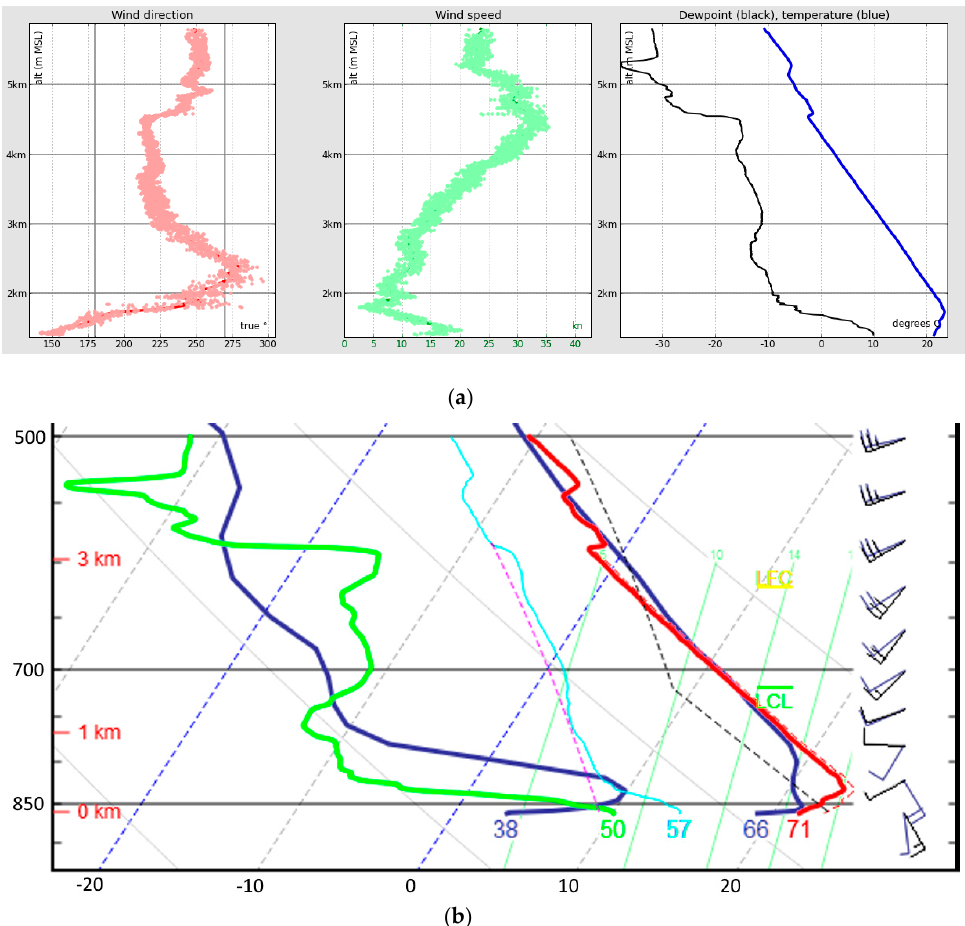
Figure 9. ( a ) Wind, temperature, and dew point profiles east of Alpine (103.5 W) from Windsond software. ( b ) Skew-T log-p plot comparing Windsond (red; green) to the 0400 UTC HRRR profile. Using a combination of HRRR, Windsond, and surface observations, vertical cross-sections of at 2200 and 0400 UTC illustrate the relation of the moist air mass to regional terrain (Figure 10). The cross-sections were analyzed using a subjective combination of mobile surface, fixed surface, radiosonde, and HRRR model data. The HRRR data from each model level were plotted at a 0.5 degree of longitude intervals and other strategic locations along the mobile track, and were adjusted to reduce local biases noted by comparison with radiosonde data. It is assumed that observed soundings provide ideal vertical resolution where available, surface mobile data provide ideal horizontal resolution of near-surface features, and the HRRR model data are able to broadly depict upper-air patterns between radiosondes. The 0.5 degree spacing of profiles appeared adequate to capture the scales of relevant coherent structures noted in model level plots, except near the surface, dryline, and areas of organized convection (not crossing the transect). Profiles were chosen closer together in the proximity of the dryline for Figure 10b. Near the soundings and near the surface, much more weight was given to the observed versus model data so that the horizontal dryline gradient and vertical inversion gradient could be represented better than through model data alone. The 15 km spatial displacement of the dryline by the HRRR was accounted for. A similar procedure was utilized by [20]. Between 2200 UTC and 0400 UTC, the cross-sections show the westward upslope retrogression of the dryline. The lowest 500 m or so on the moist side generally have mixing ratios greater than 8 g/kg, while air to the west of the dryline is well under 4 g/kg. The moist layer is trapped below a subsidence inversion, although the HRRR model does indicate some upward transport within about 50–100 km to the east of the dryline boundary.